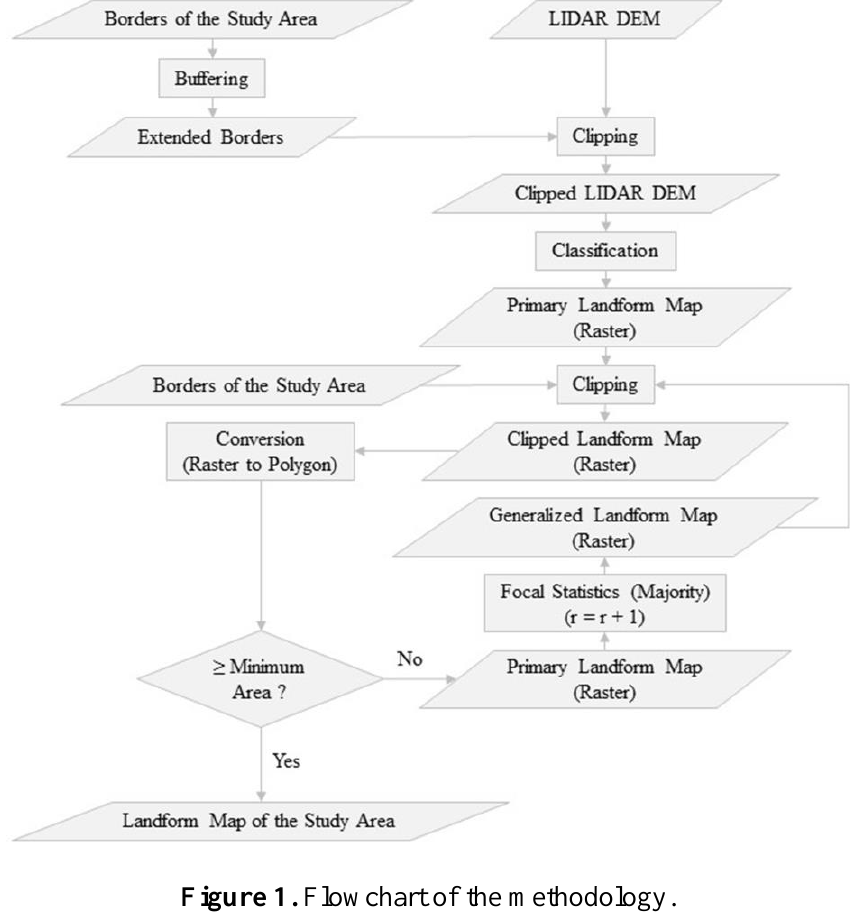
Figure 1. Flowchart of the methodology.